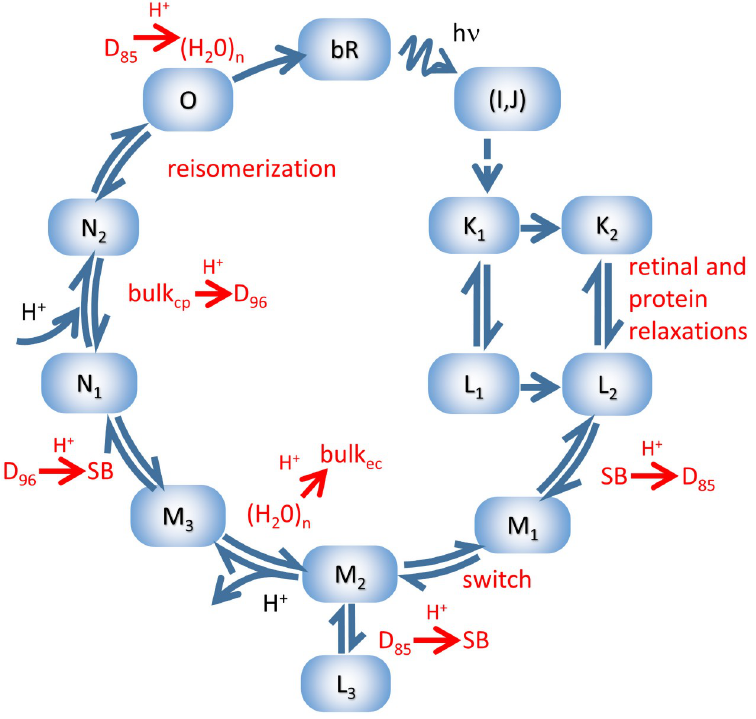
Scheme 2 . Model of the bR photocycle providing input data for the simulations . All dark reactions between the intermediates are supposed to be first-order ones. See S1 Table for the corresponding microscopic rate